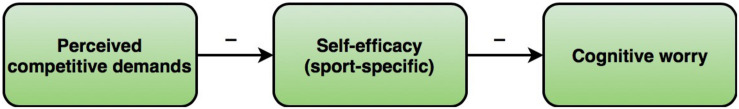
Reduced model based on research findings, with plus and minus signaling the direction of hypothesized relationships.